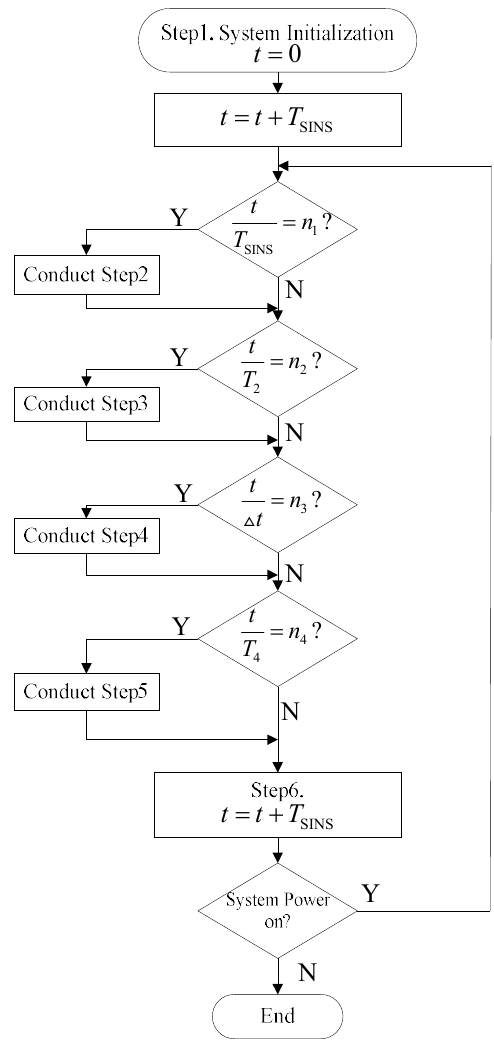
Figure 5. Algorithm